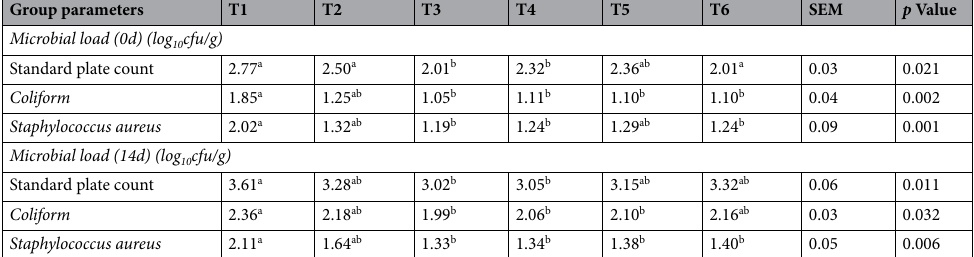
Table 6. Effects of dietary inclusion of prebiotics on microbial load of fresh and refrigerated (14 d) meat in broiler chickens. T1 (no MOS/FOS/BMD), T2 (0.002% BMD), T3 (T1 + 0.1% MOS), T4 (T1 + 0.2% MOS), T5 (T1 + 0.1% FOS), T6 (T1 + 0.2% FOS). SEM = Standard error of mean; n = 15. Mean values bearing the same superscript in a row did not differ significantly ( p <